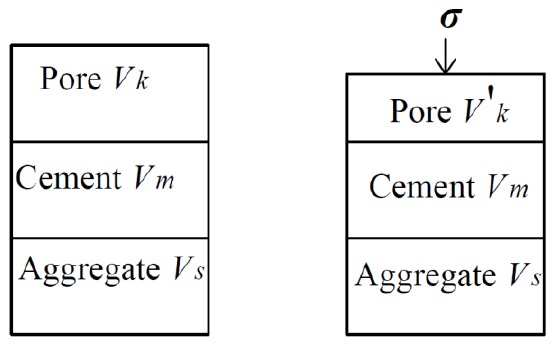
Figure 1. Composition of concrete.